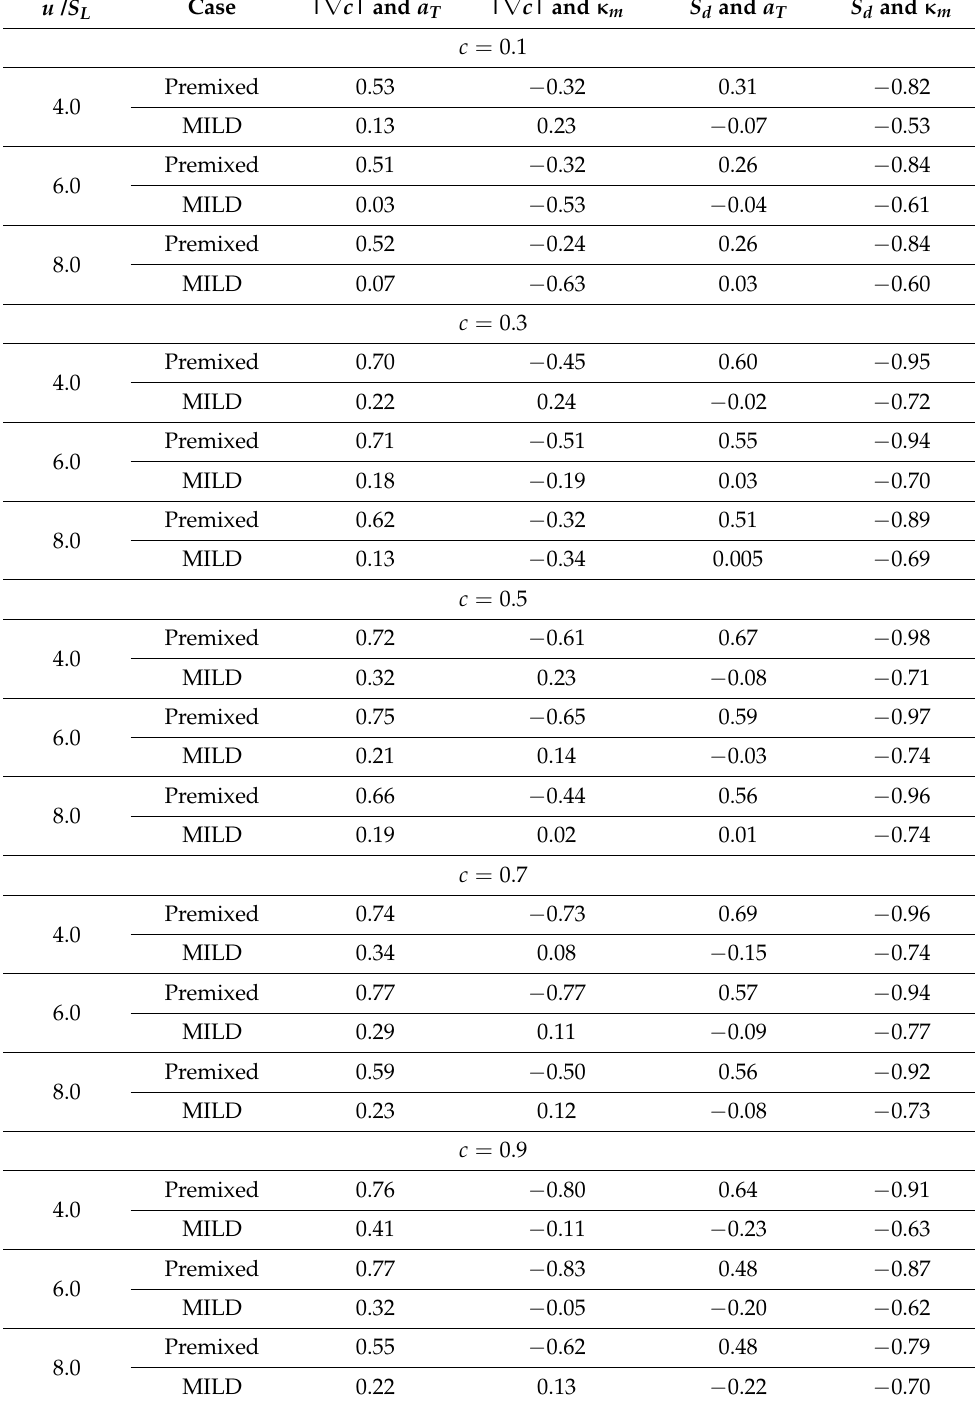
Table 3. Correlation coefficients of |∇ c | and S d with a T and κ m for c = 0.1, 0.3,0.5,0.7 and 0.9 isosurfaces. The u (cid:48) / S L values in this table are the initial